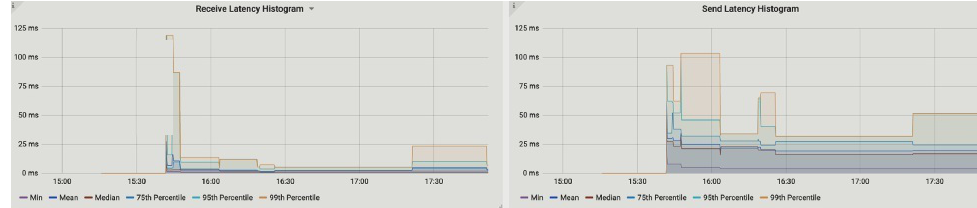
Figure 9. Receive and send latency